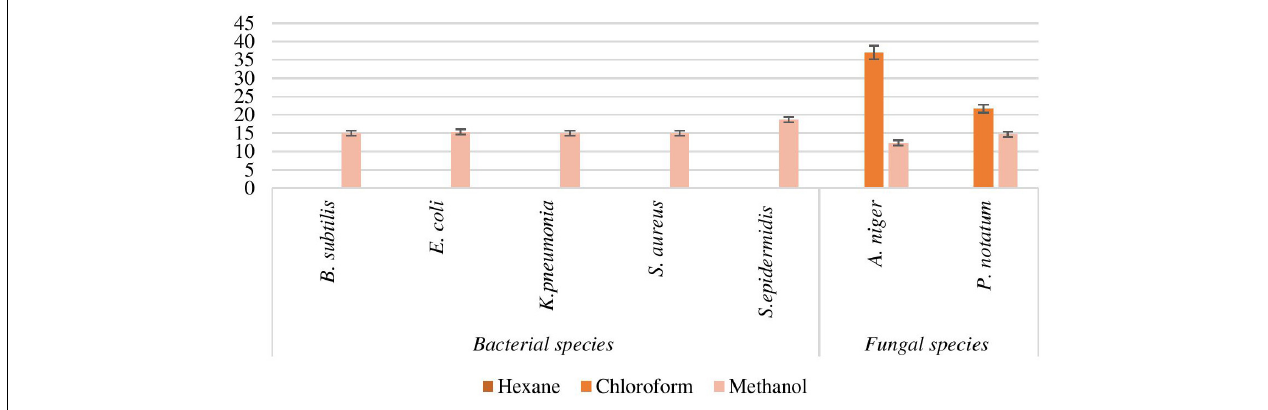
FIGURE 7 | Antimicrobial activity of Padina antillarum (Kützing) Piccone.